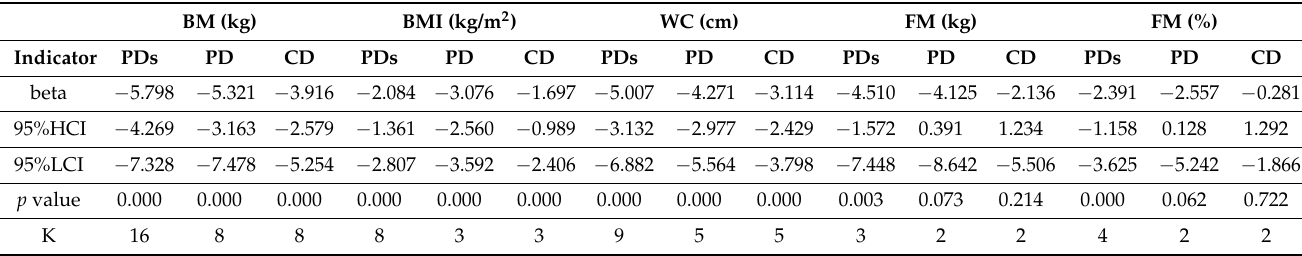
Beta: the size of the average effect (within group); 95% HCI and 95% LCI: limits of 95% confidence interval of the effect; p -value: significance level of the intra-group effect. Results statistically significant at least at the 0.1 significance level are marked red; k: number of studies included; PDs: experimental group (both PD vs. CD and PD pre vs. post; PD vs. PD + EX); PD: experimental group limited only to PD vs. CD studies; CD: control